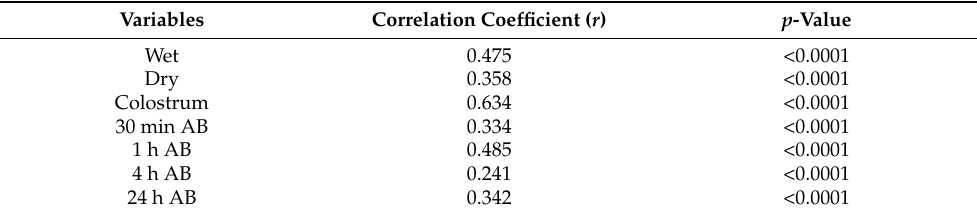
Table 11. Significant correlations between the weight of the dam and the superficial temperature at thoracic limb metacarpals (TLM) window in newborn puppies at different times: wet (with amniotic fluid), dry (once the puppy was rubbered), colostrum (after colostrum intake and separated from